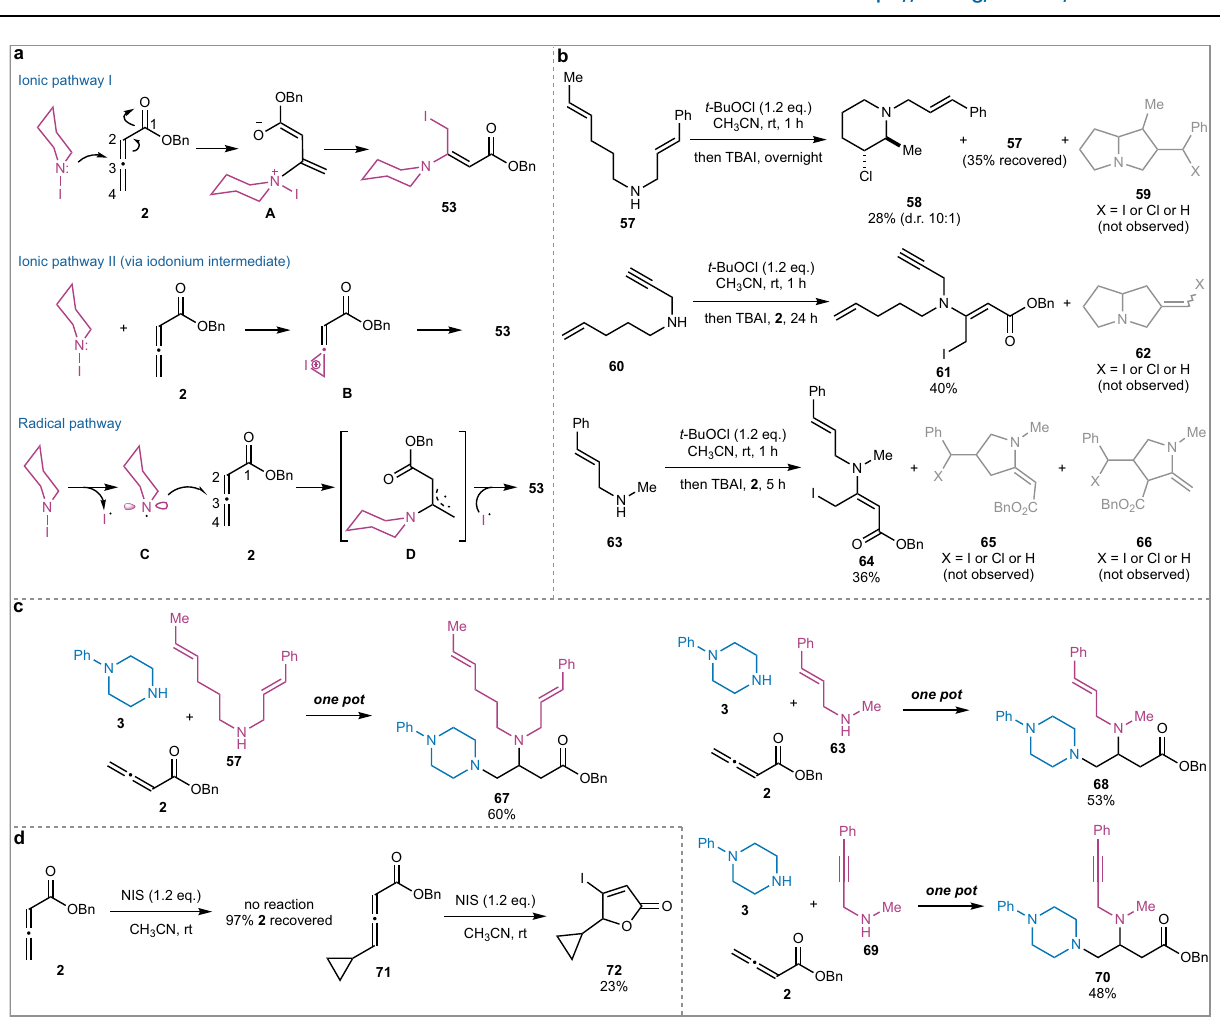
69 under standard diamination conditions. d Reactions of allenoates 2 and 71 with NIS. TBAI tetra- n -butylammonium iodide. NIS N